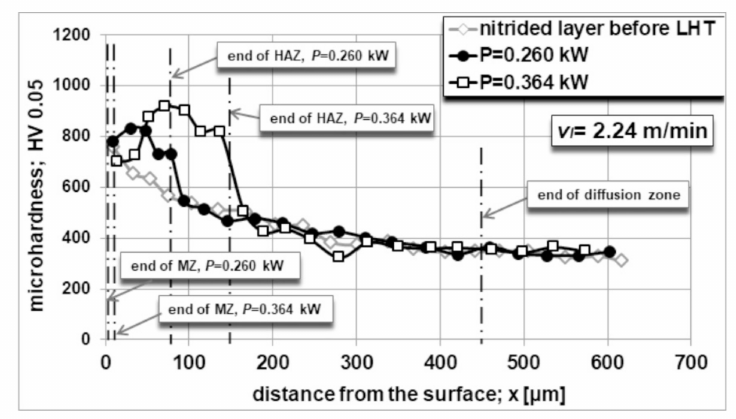
Figure 9. Microhardness profiles in single laser tracks produced on gas-nitrided 42CrMo4 steel using a scanning rate v l = 2.24 m · min − 1 and di ff erent laser beam powers: P = 0.260 kW and P = 0.364